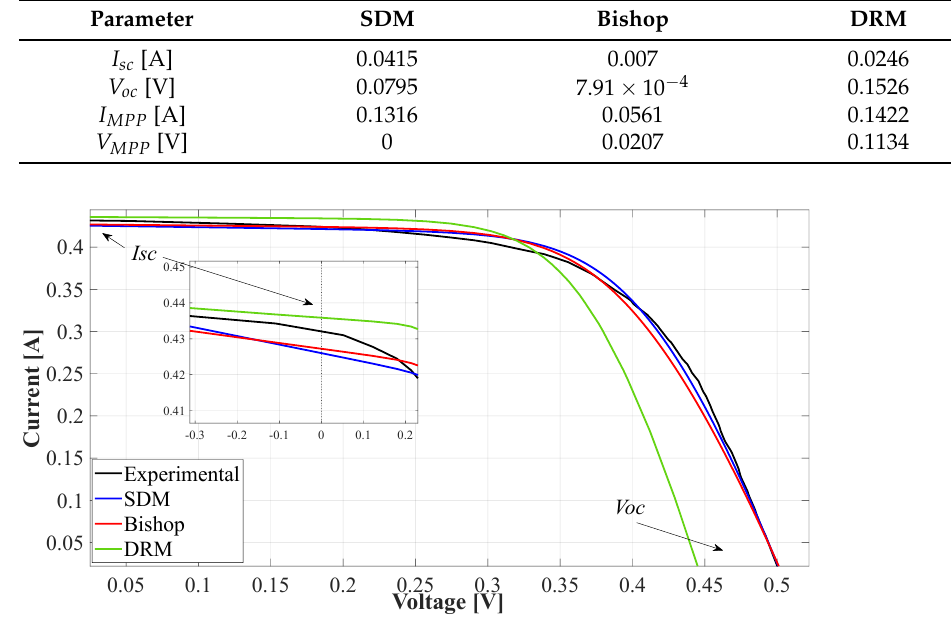
Figure 8. Comparison between the experimental and estimated curves (zoom-in for I sc